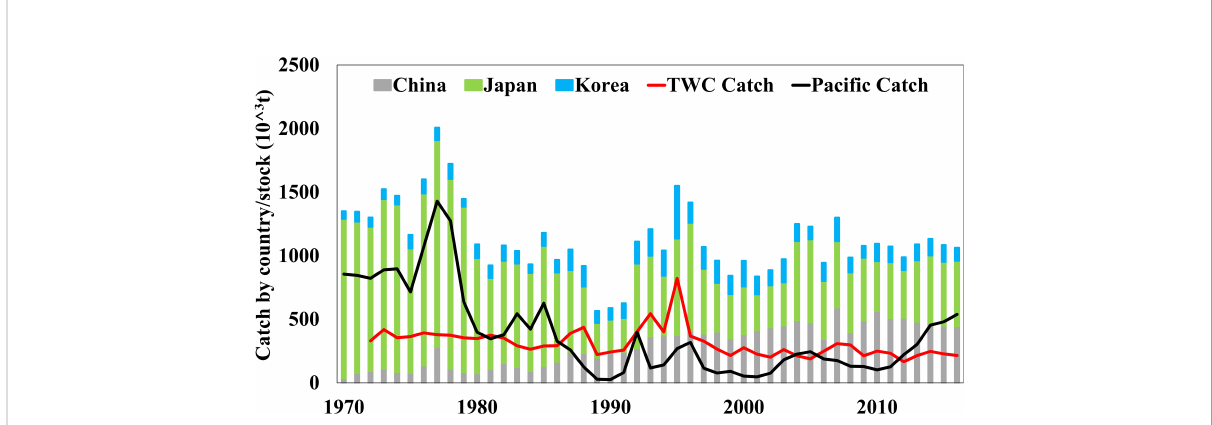
FIGURE 1 Variations in annual catches of chub mackerel by countries/stocks from 1970 to 2017 (FAO-FIGIS, 2018; Kurota et al., 2018; Yukami et al.,